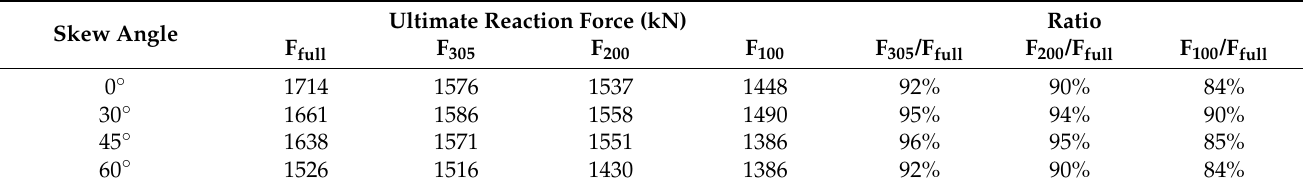
Table 3. Effect of varying skew